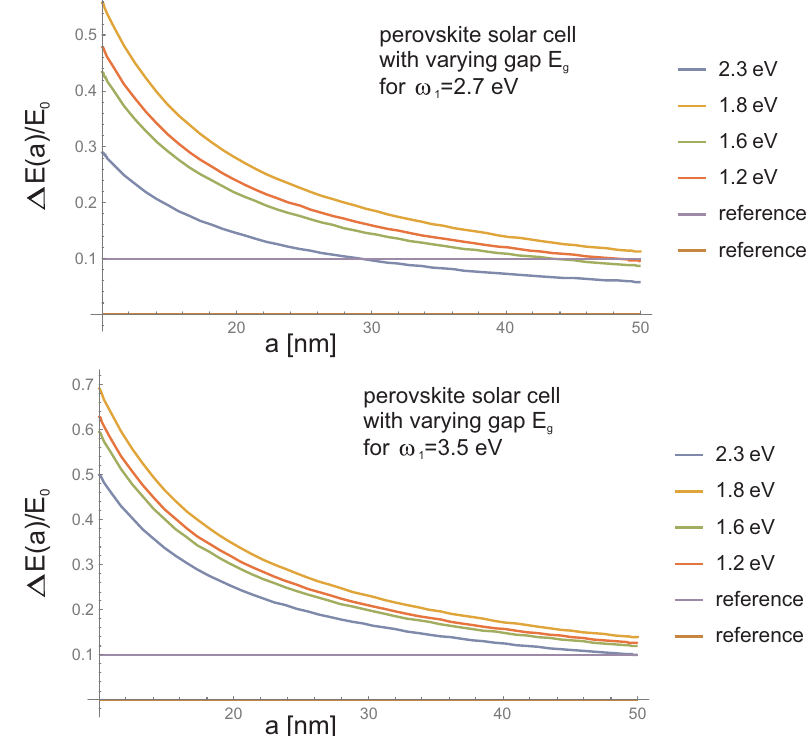
Figure 12. Reduction of the binding energy of excitons created by plasmons versus size of the metallic nanoparticles for several representatives of perovskite family with various forbidden gaps ( E g = 2.3, 1.8, 1.6,1.2 eV) and for metallization with Au nanoparticles ( ω 1 = 2.7 eV) – upper panel, and for blue shifted plasmon resonance ( ω 1 = 3.5 eV) – lower panel. The reduction of binding energy m ∗ n m ∗ p ∆ E ( a ) / E 0 is normalized by the energy of electron with reduced mass µ = at the edge of the m ∗ n + m ∗ p 2 Brillouin zone, E 0 = p , for p = ¯ h π and l = 5 nm – the averaged linear size of the elementary cell of 2 µ l perovskite. The reducing of exciton binding energy is calculated according to Eq. (18) (Mathematica software).